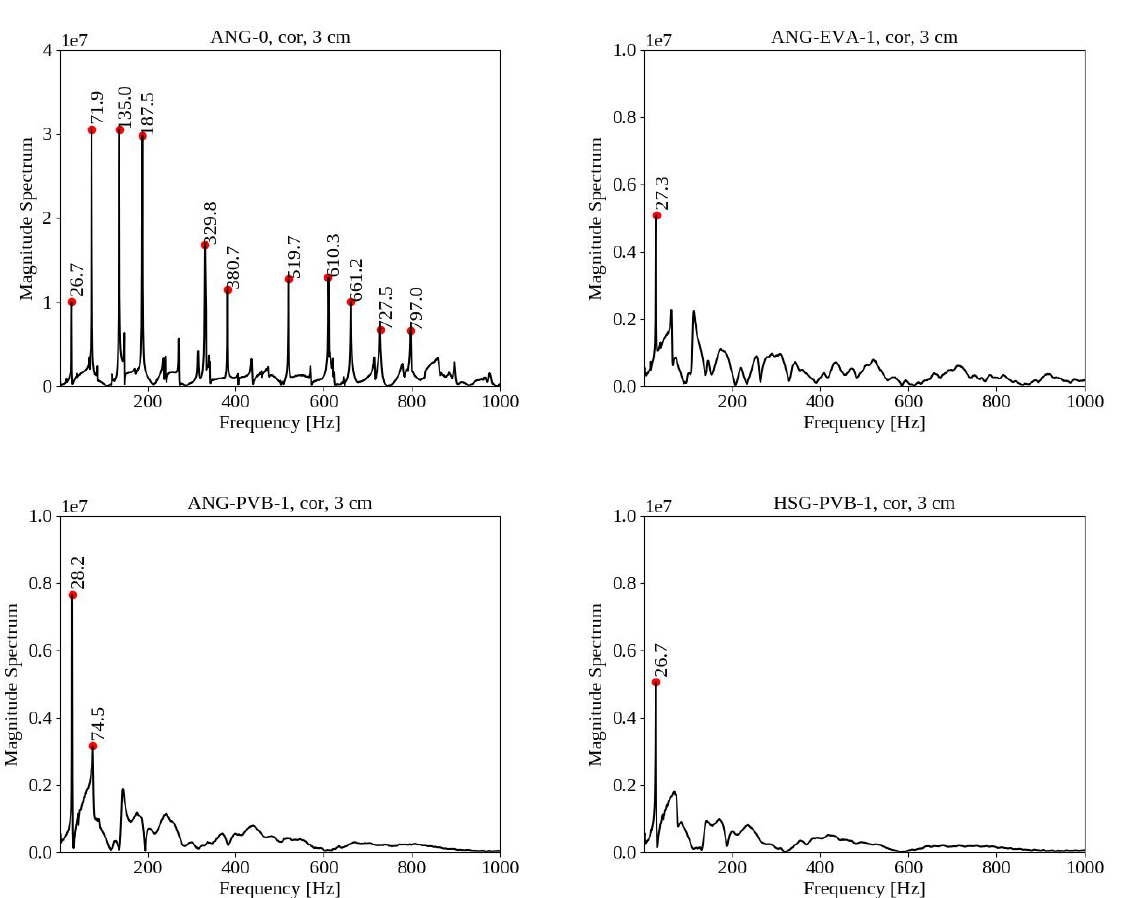
Fig. 4 FFT analysis of the signal from the accelerometer in the corner of a monolithic or laminated glass sample.